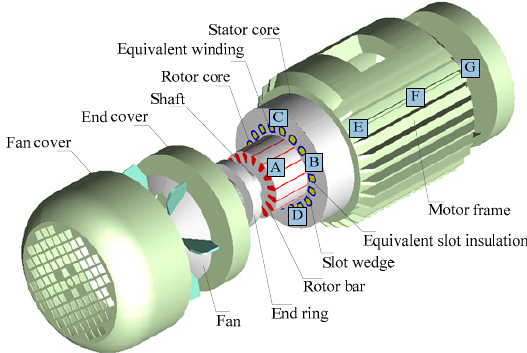
Figure 2. 3D model of the motor.